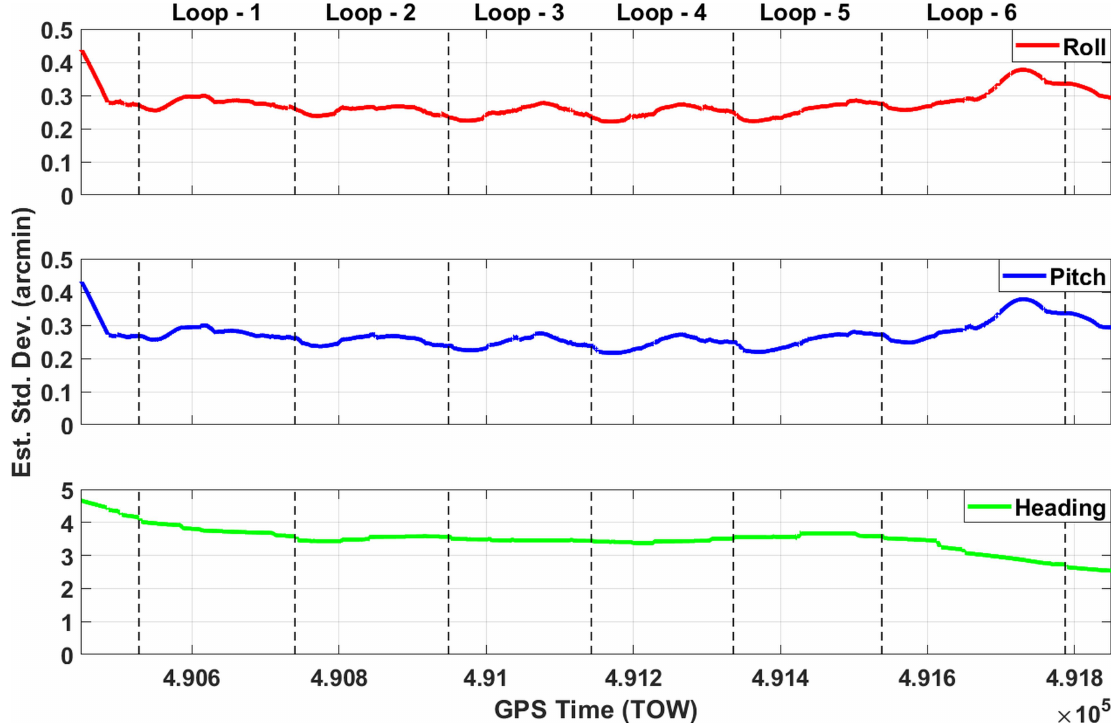
Figure 7. Estimated standard deviations of the roll, pitch, and heading angles of the GNSS/IMU